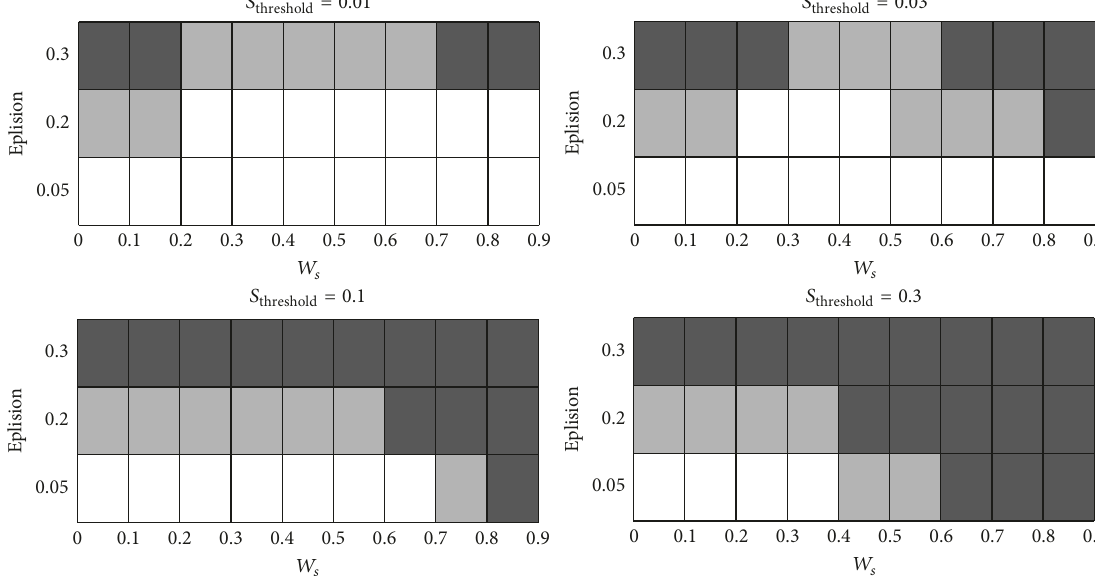
Figure 2: Opinion evolution result under the mutual influence of social similarity and the confidence bound of different 𝑤 𝑠 (the dark gray, white, and light gray areas represent opinion consensus, opinion polarization, and opinion fragmentation,